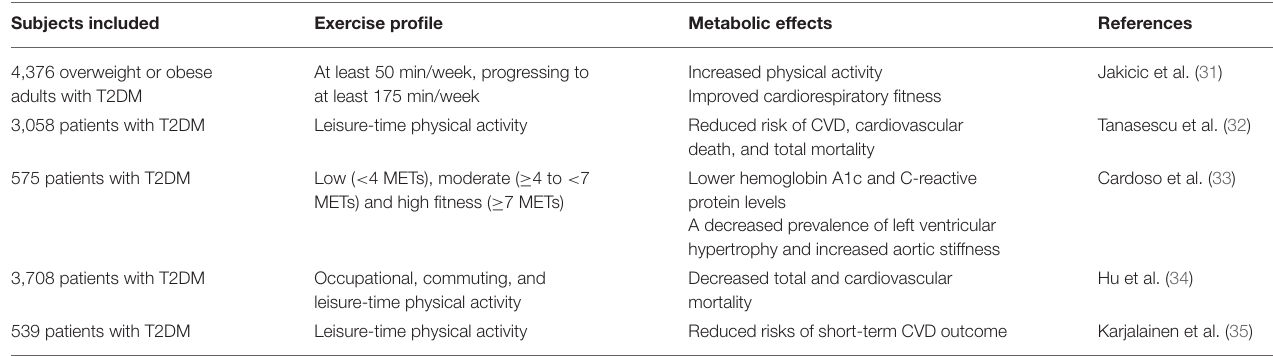
TABLE 1 | Clinical studies about exercise and diabetes-related cardiovascular diseases. Subjects